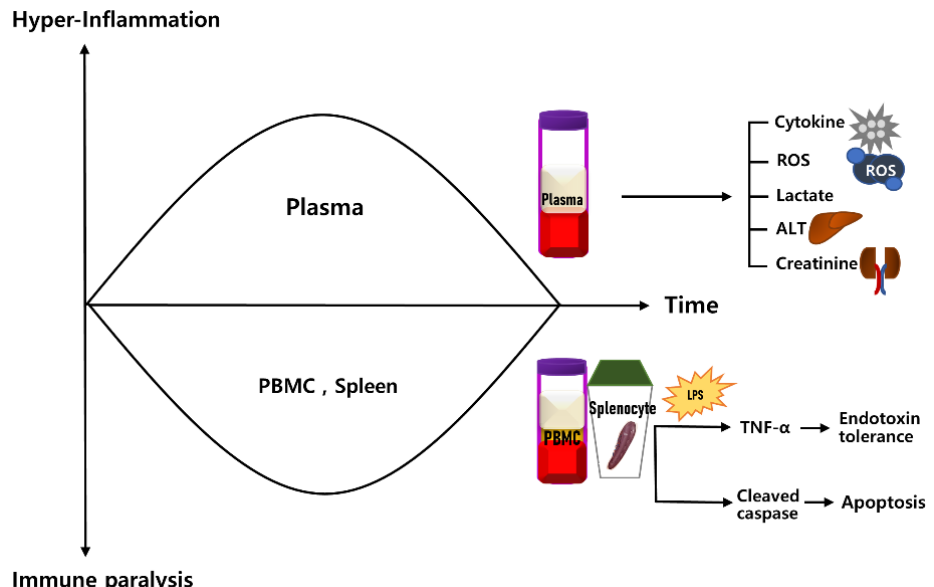
Figure 1. Overview of the serial change of endotoxin tolerance in experimental sepsis model. Schematics showing hyperinflammation in plasma level, but simultaneously, immune suppression and apoptosis in PBMCs and splenocytes.